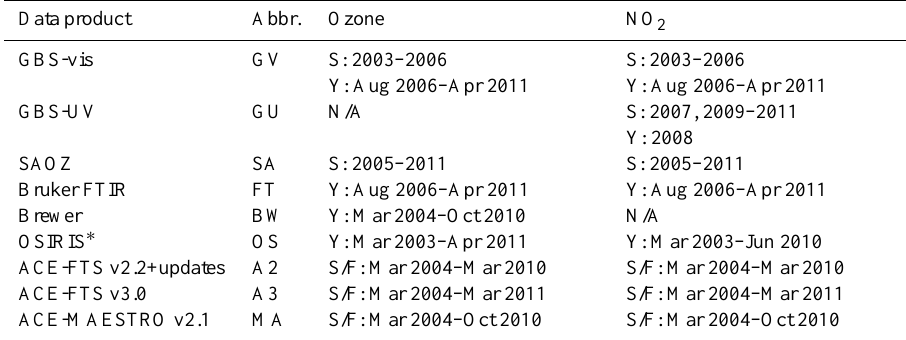
Table 1. Measurement dates for data included in this intercomparison. (Abbr.=abbreviation used in figure and table captions throughout this paper; S=spring only, F=fall only, Y=year-round excluding polar night).